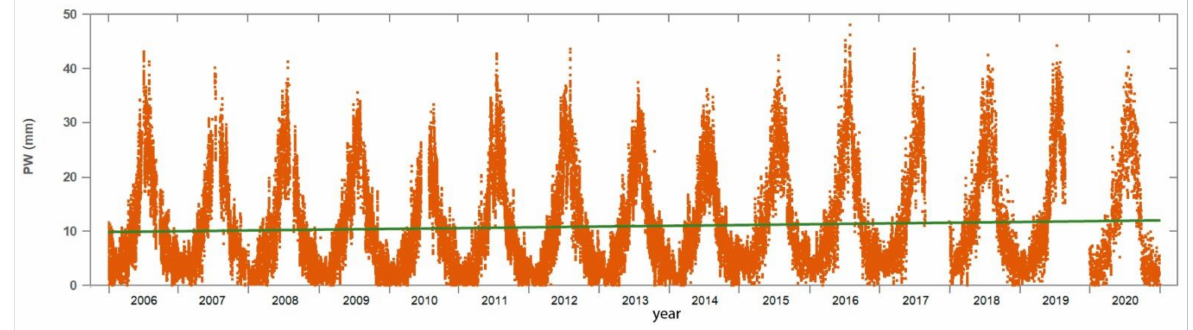
Figure 9. Time series of measured PW values at the BADG for the period 2006–2020. The green line is the general linear